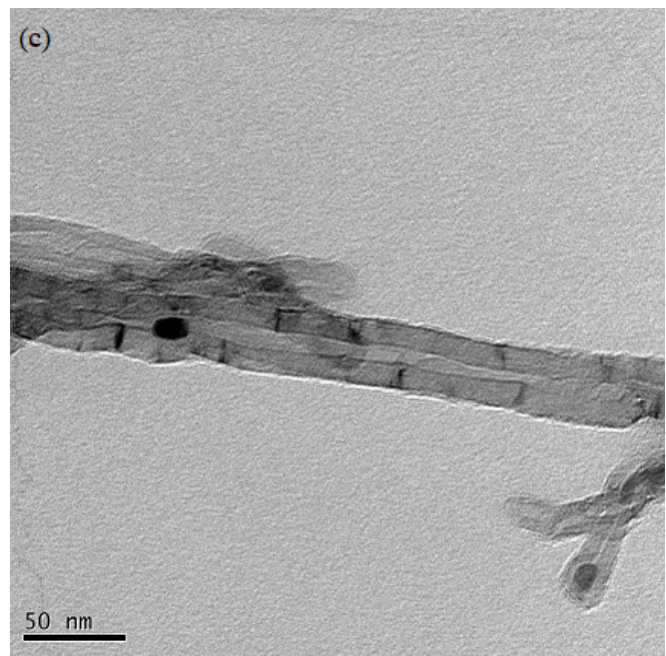
Figure 13. HRTEM images of purified MWCNTs ( a ) 0.2 µm, ( b ) 100 nm, and ( c ) 50 nm.